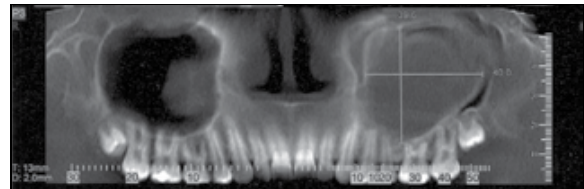
Figura 2 – Tomografia Cone Bean: imagem panorâmica da lesão acometendo seio maxilar